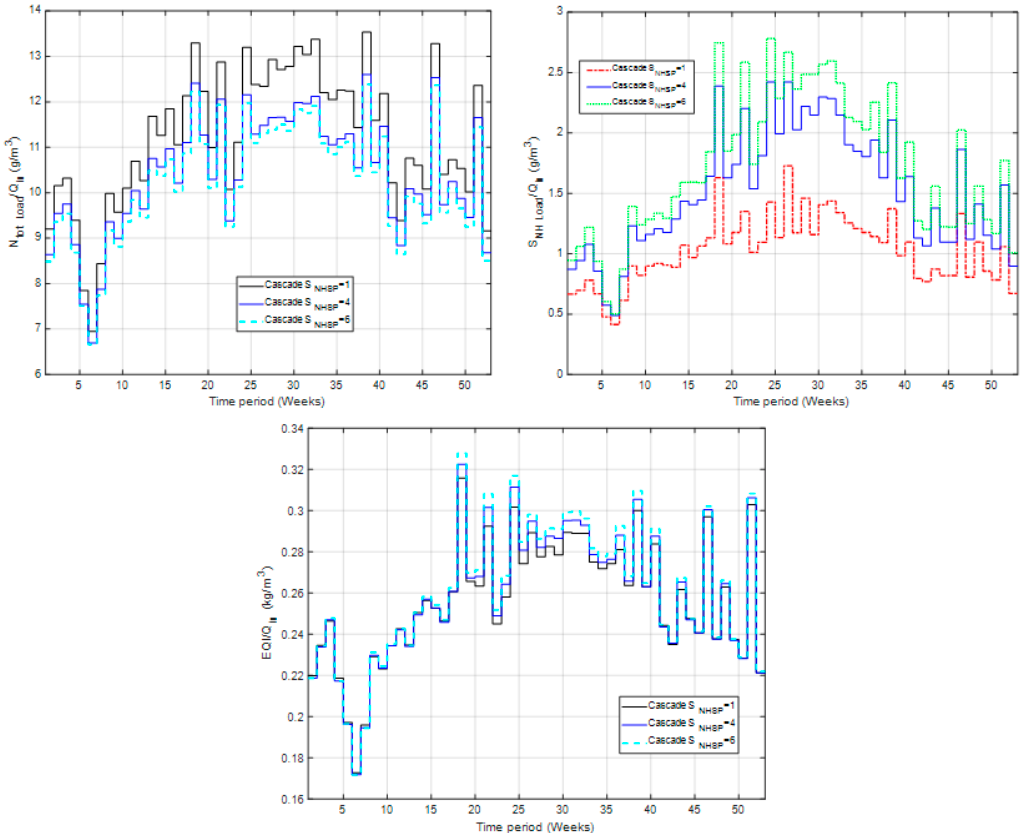
Figure 8. Weekly profiles of environmental indicators associated with emissions to water: N tot Load /Q in (g/m 3 ), S NH Load /Q in (g/m 3 ) and EQI/Q in (kg/m 3 ) under the ammonium-based control scheme (Cascade S NHSP ).